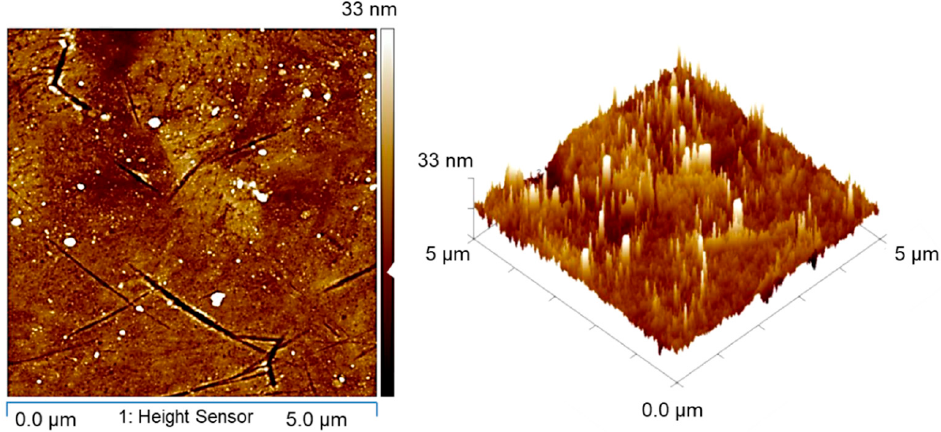
Figure 1. Typical AFM image of the Cu joints showing a roughness ( R q ) of ~3 nm.